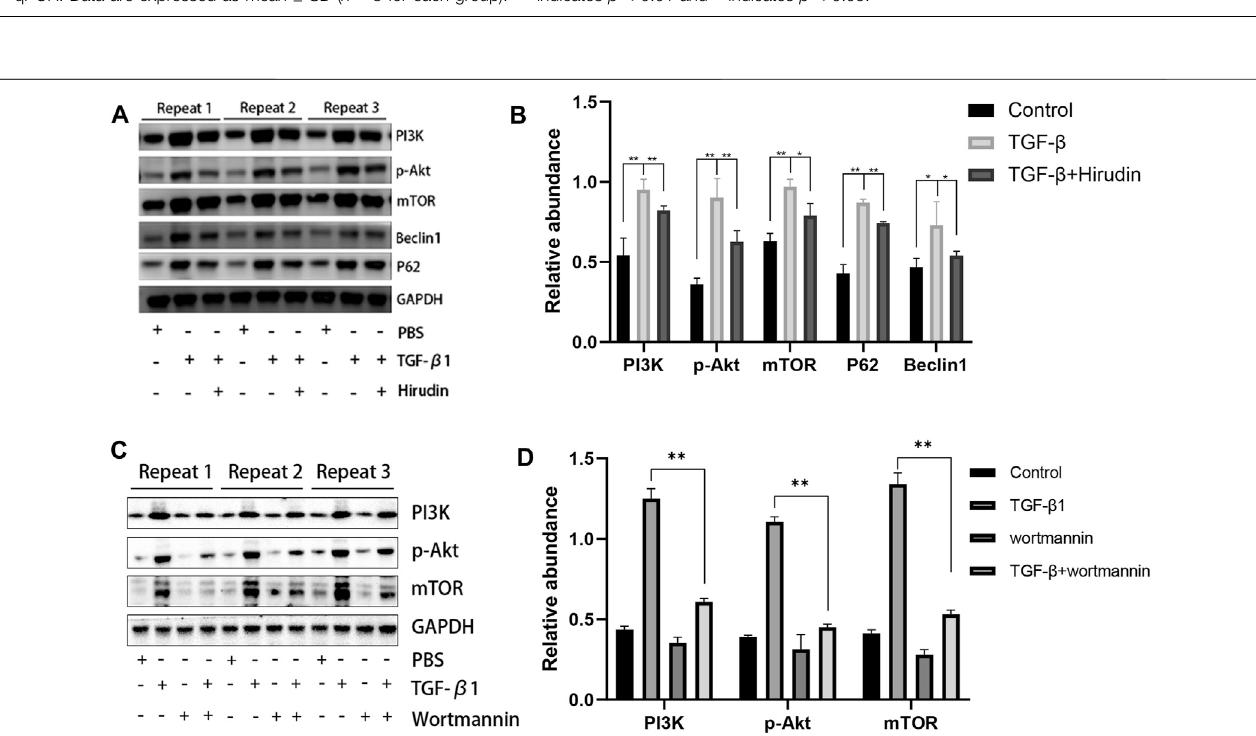
FIGURE7| Hirudininhibits the PI3K/Akt signaling pathway in TGF- β 1-treated NRK-52E cells. (A) Effect ofhirudin on PI3K, p-Akt,mTOR, Beclin1 and P62inTGF- β 1-treated NRK-52E cells, as determined by Western blot. (B) Effect of hirudin on PI3K, p-Akt, mTOR, Beclin1 and P62 in TGF- β 1-treated NRK-52E cells, according to the results of Western blot. (C) Effect of wortmannin on PI3K, p-Akt, mTOR in TGF- β 1-treated NRK-52E cells, as determined by Western blot. (D) Effect of wortmannin on PI3K, p-Akt, mTOR in TGF- β 1-treated NRK-52E cells, according to the results of Western blot. Data are expressed as mean ± SD ( n (cid:2) 3 for each group). pp indicates p < 0.01 and p indicates p <